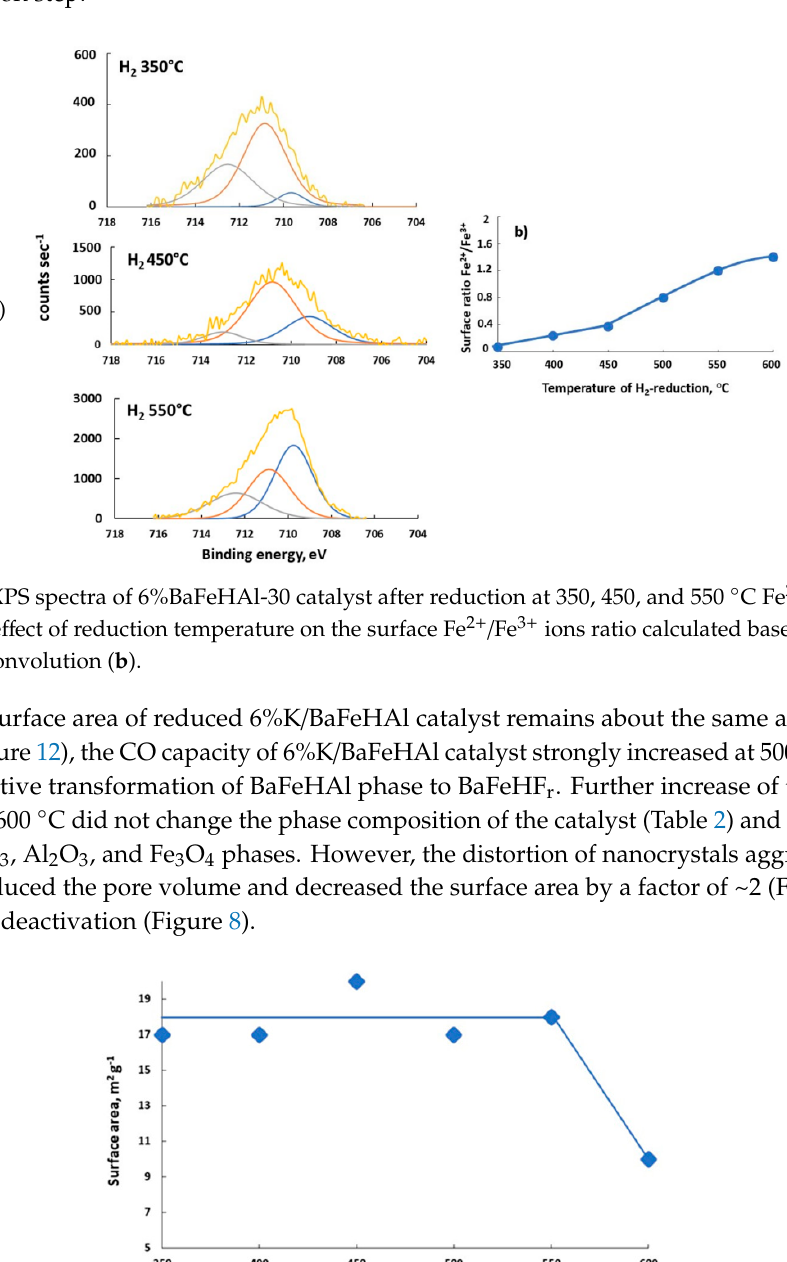
( b ) Figure 10. The oxygen environments of Fe atoms represented as tetrahedra and octahedra in two modifications of BaFeHF phase: ( a ) BaFeHF co-pre ; ( b ) BaFeHF r . The colors correspond to groups of atoms as defined in Fig.1b, c —Fe 1 ; —Fe 2 ; —Fe 3 ; —Fe 4 ; —Fe 5 ; —Ba. Shown in Figure 11 are the XPS spectra of the material 6%K/BaFeHAl reduced at 350–550 °C. The existence of iron ions at different valence state and environment follows from deconvolution of